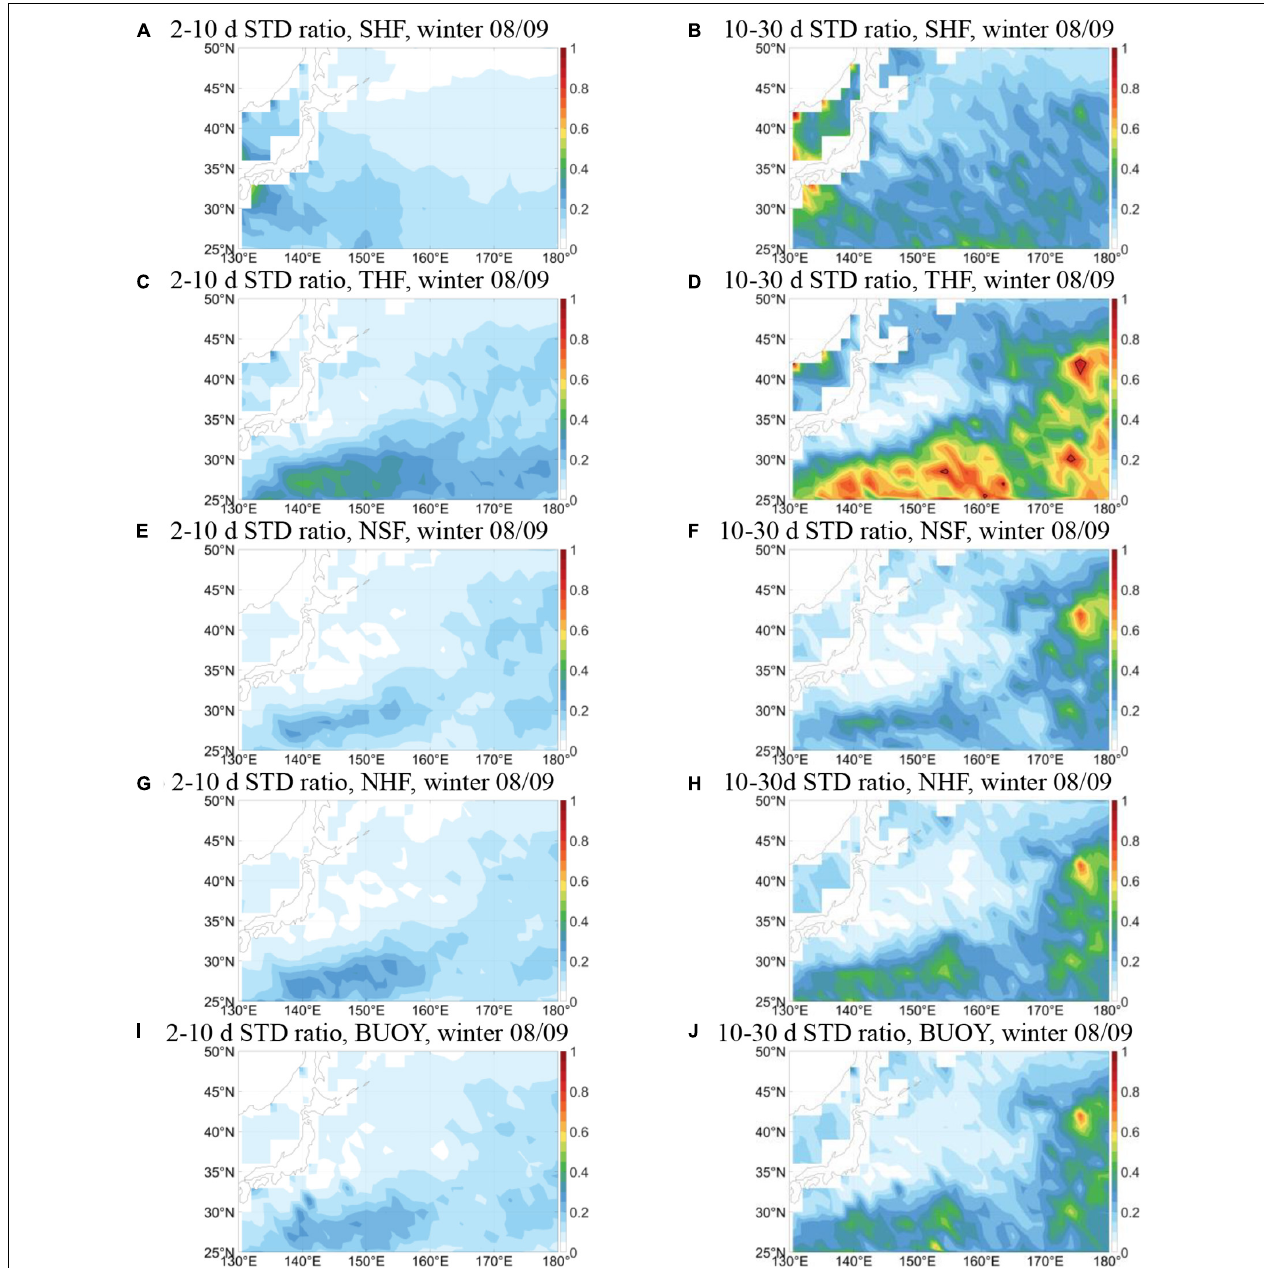
FIGURE 6 | Ratio of standard deviation between GOTM sensitivity experiments and observations in winter 2008/09 on (A,C,E,G,I) 2–10 days and (B,D,F,H,J) 10–30 days timescales. The black contour indicates the critical ratio at the 95% significance level.